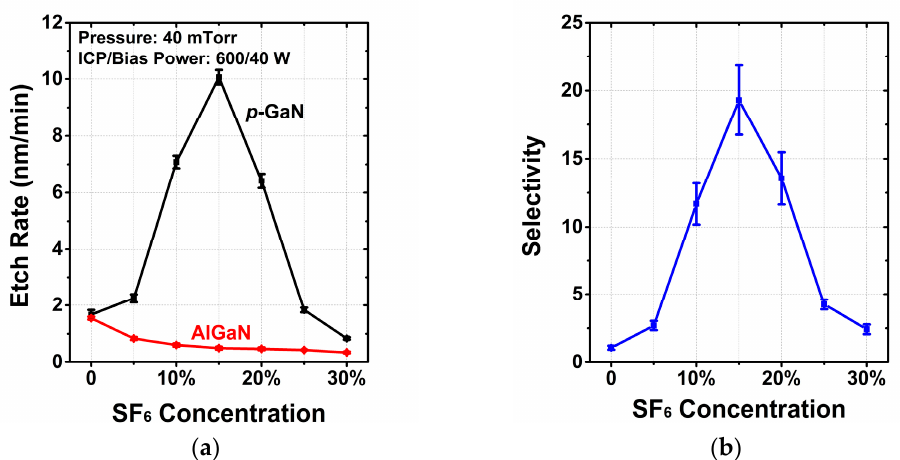
Figure 1. Dependence of ( a ) the etch rates, ( b ) selectivity between p -GaN and AlGaN on SF 6 concen- tration.